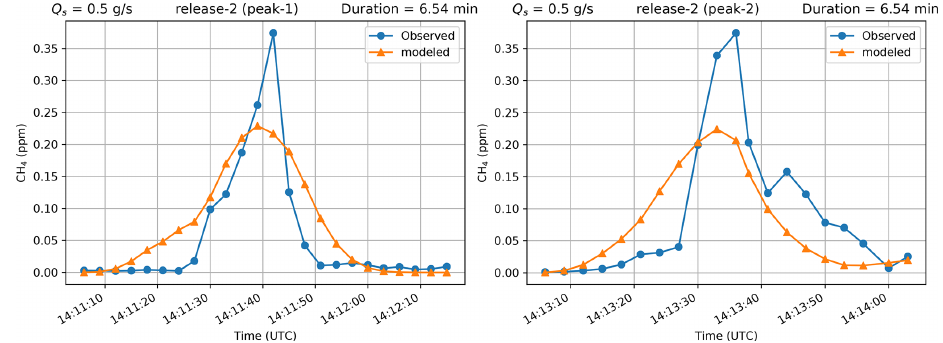
Figure 4. Observed and modeled peaks in the CH 4 mole fractions for two plume cross sections used in the inversion for release no. 2, using the estimates of the source location and rate from the inversion.